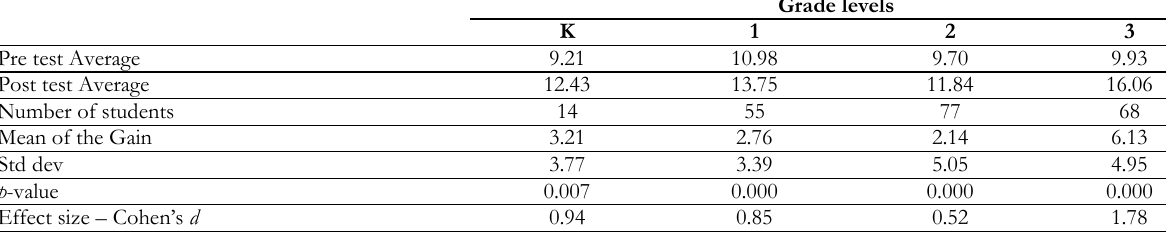
Figure 3. Student Conceptions about What Is Engineering? Table 6. What is Technology? Assessment Results